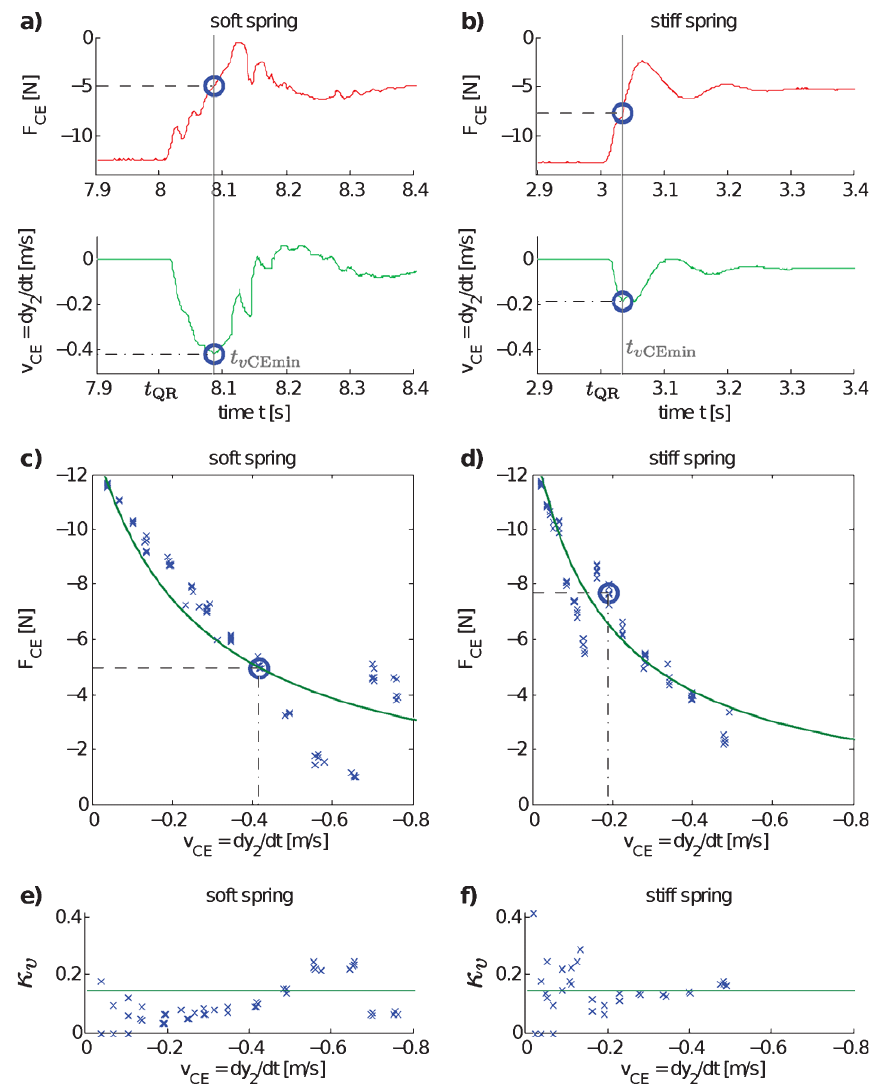
Fig. 5. QR results with SE soft spring ( k SE = 369Nm − 1 ) and SE stiff spring ( k SE = 2401Nm − 1 ). a) and b): Force and contraction velocity of the CE during a quick release experiment (QR load: m = 0 . 523kg). The load was released at t QR . The contraction velocity v CE reached a minimum at t v CE min (circle). F CE ( t v CE min ) and v CE ( t v CE min ) were extracted. c) and d): Force velocity relation F CE ( t v CE min ) vs. v CE ( t v CE min ) derived from QR experiments. The circle refers to the QR experiment shown in Fig. a) and b). A hyperbola was fitted to the data (fit parameters see table 1). It deviates from the theoretical prediction (Fig. 1). e) and f): actual (x-marks) and assumed (solid line) ratio between SE and CE contraction velocity κ v ( t ) = ( v CE ( t ) − v AE ( t )) /v CE ( t ) for t = t v CE min .